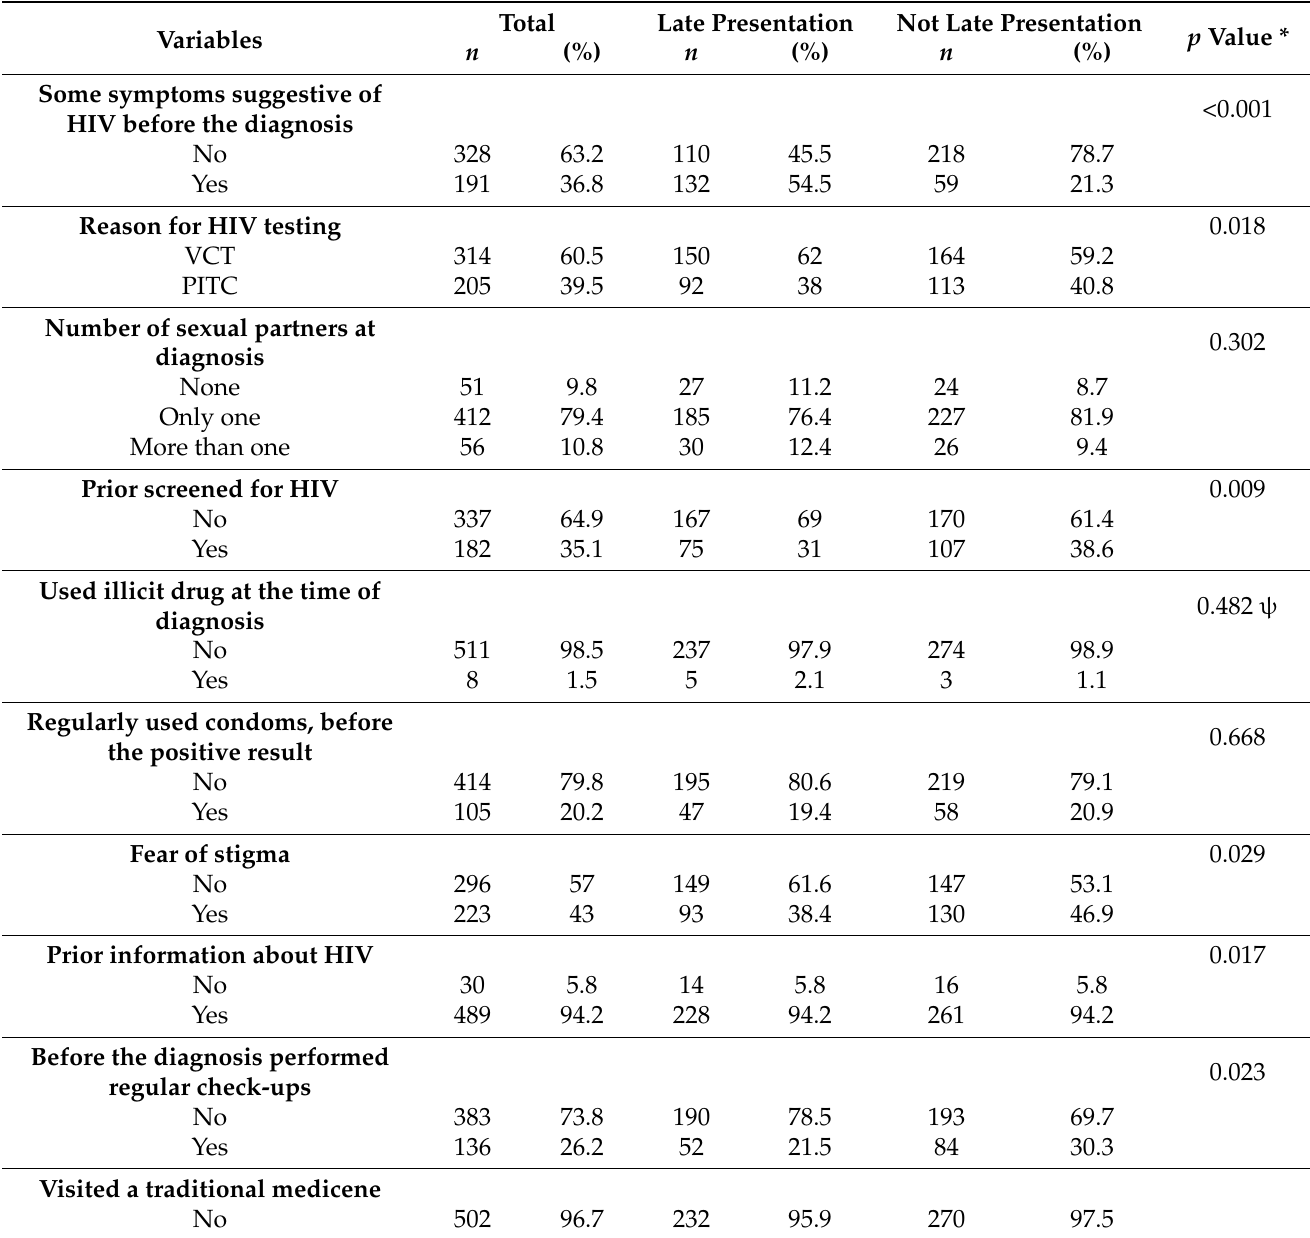
Table 2. Behavioral factors of study participants at the Ndlavela Health Center,